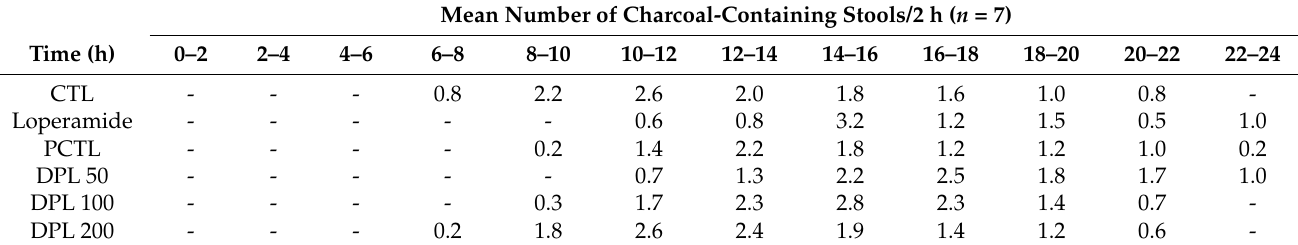
Table 4. The therapeutic effects of D. morbiferus H. L é v. leaf extract (DPL) on gastrointestinal (GI) motility in rats. Mean Number of Charcoal-Containing Stools/2 h ( n = 7)